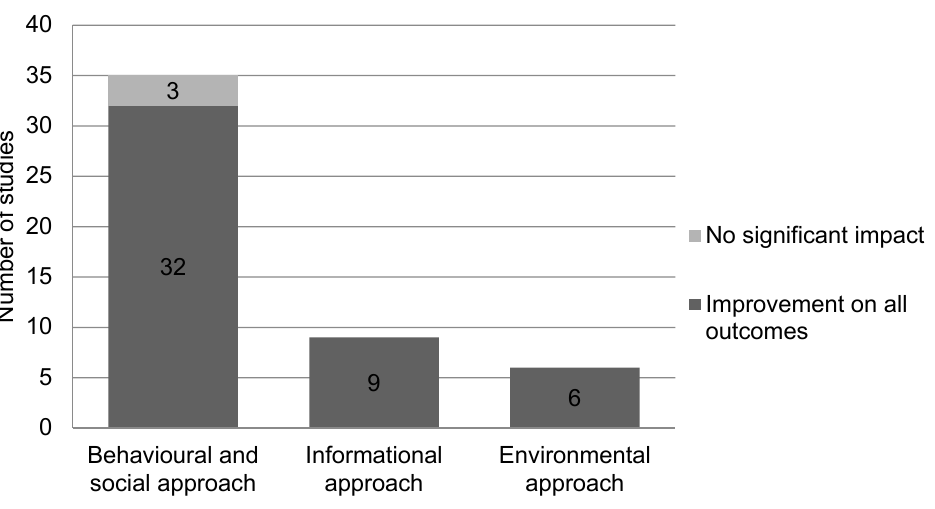
Figure 2. Impact of interventions on all outcomes.